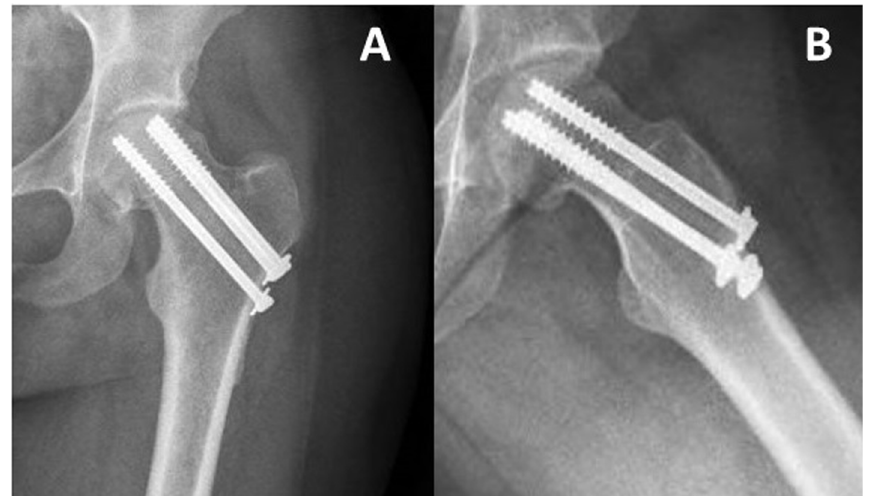
Figure 4. Anteroposterior (A) and lateral (B) radiographs performed on the latest follow-up, 24 months postoperatively, demonstrates consolidation of the fracture with no hardware migration nor intra-articular